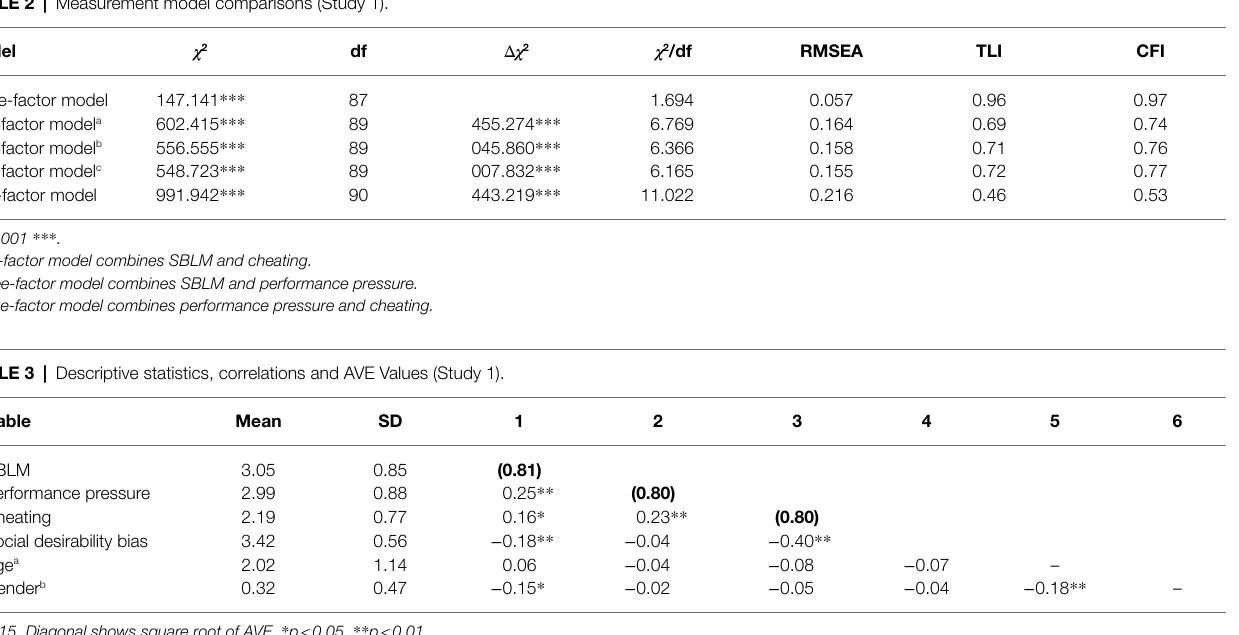
TABLE 2 | Measurement model comparisons (Study 1).